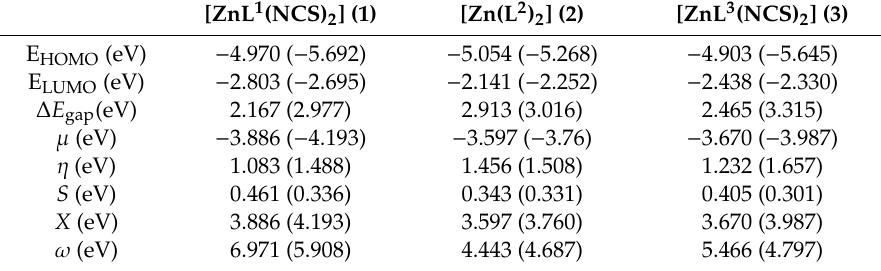
Figure 4. Molecular orbital plots and energy levels of the highest occupied molecular orbital (HOMO), the lowest unoccupied molecular orbital (LUMO) and HOMO-LUMO transitions of: ( a ) [Zn L 1 (NCS) 2 ] Table 3. Quantum chemical descriptors for complexes in vacuum and toluene (in brackets).